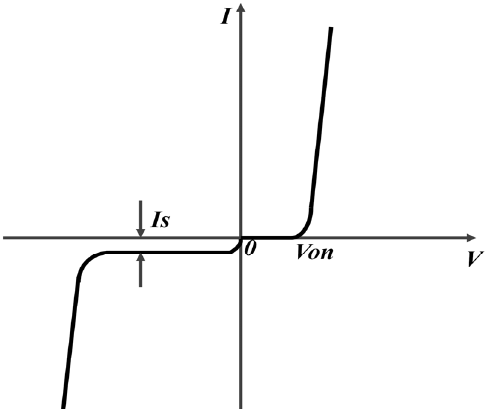
Figure 2. The I–V characteristic of the diode, 𝐼 (cid:3020) is the reverse saturation current of the diode and Figure 2. The I – V characteristic of the diode, I S is the reverse saturation current of the diode and 𝑉 (cid:3016)(cid:3015) is the turn-on voltage of the diode. V ON is the turn-on voltage of the